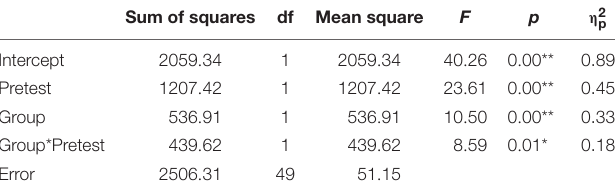
TABLE 6 | One-way ANCOVA on English language test performance between two groups. Sum of squares df Mean